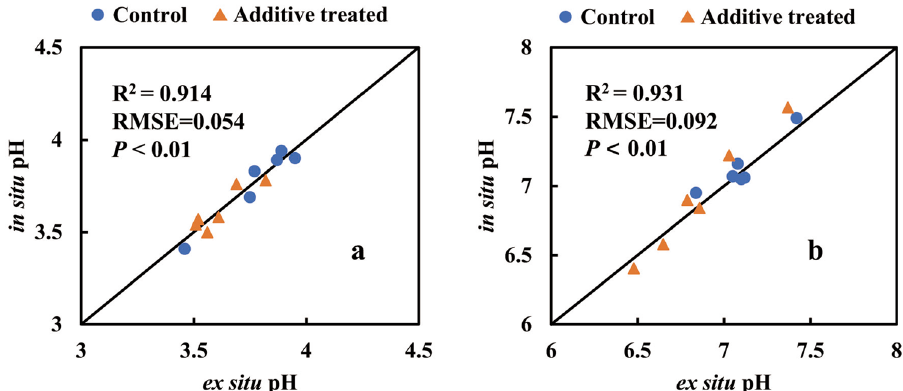
Figure 2. Piecewise comparison of in situ and ex situ pH in the 3.5 to 7.5 range (low pH group obtained before the experiment; high pH group at the end of aerobic exposure). The solid line is the line of equality. 24 paired data in the subfigures were measured from the samples in the same instrumented jar